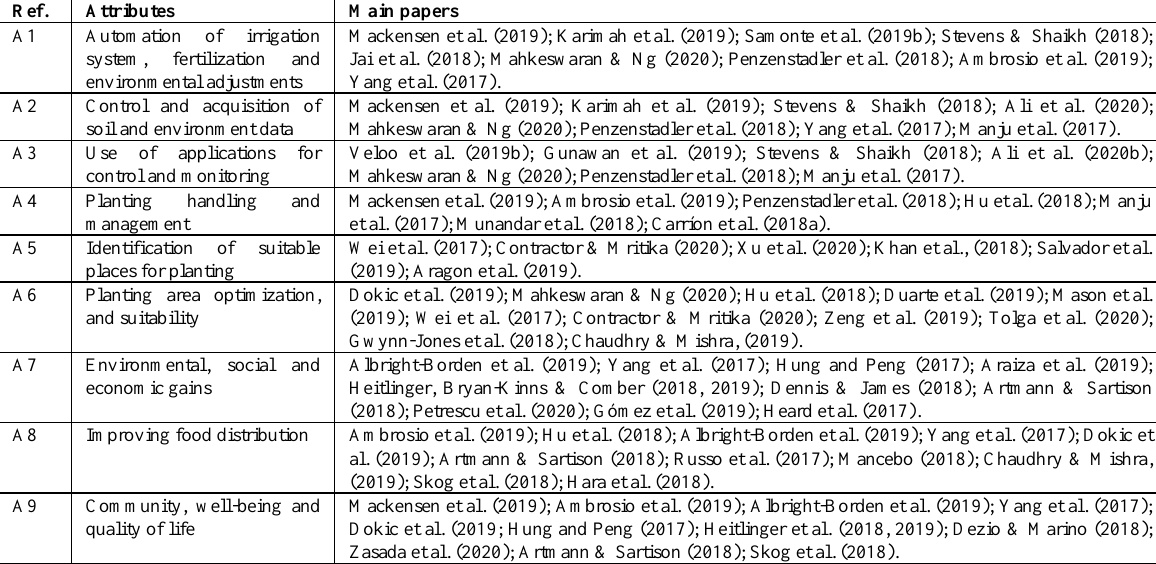
Table 3. Attributes of Urban Agriculture and main related papers identified by the systematic literature review. The corresponding codes were used in the relationship matrices.